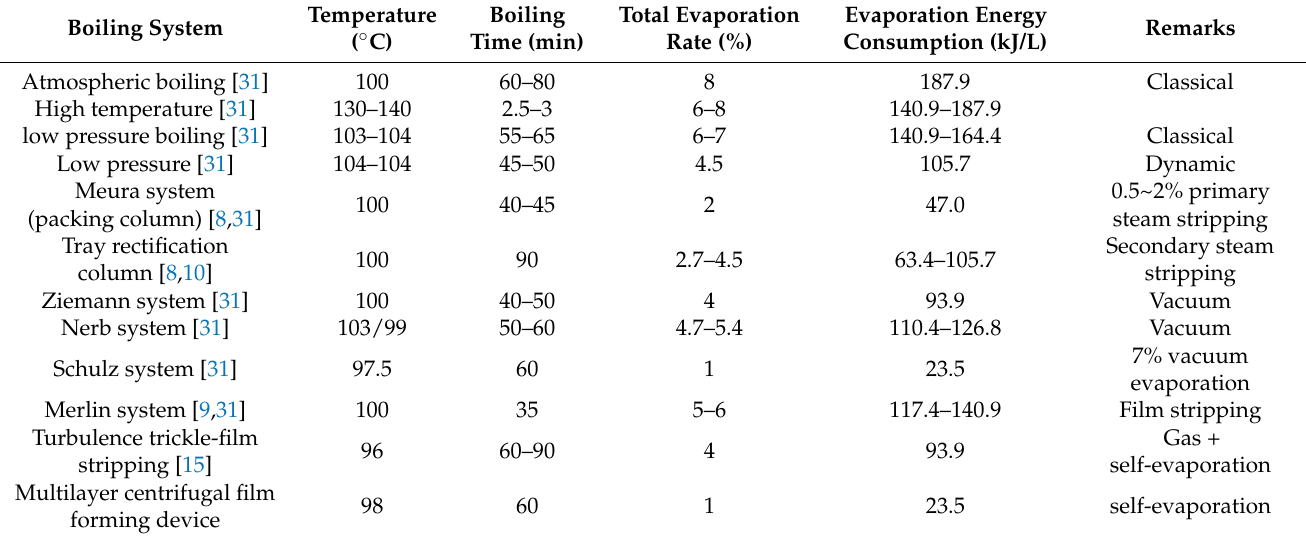
Table 3. Comparison of the evaporation energy consumption of different boiling